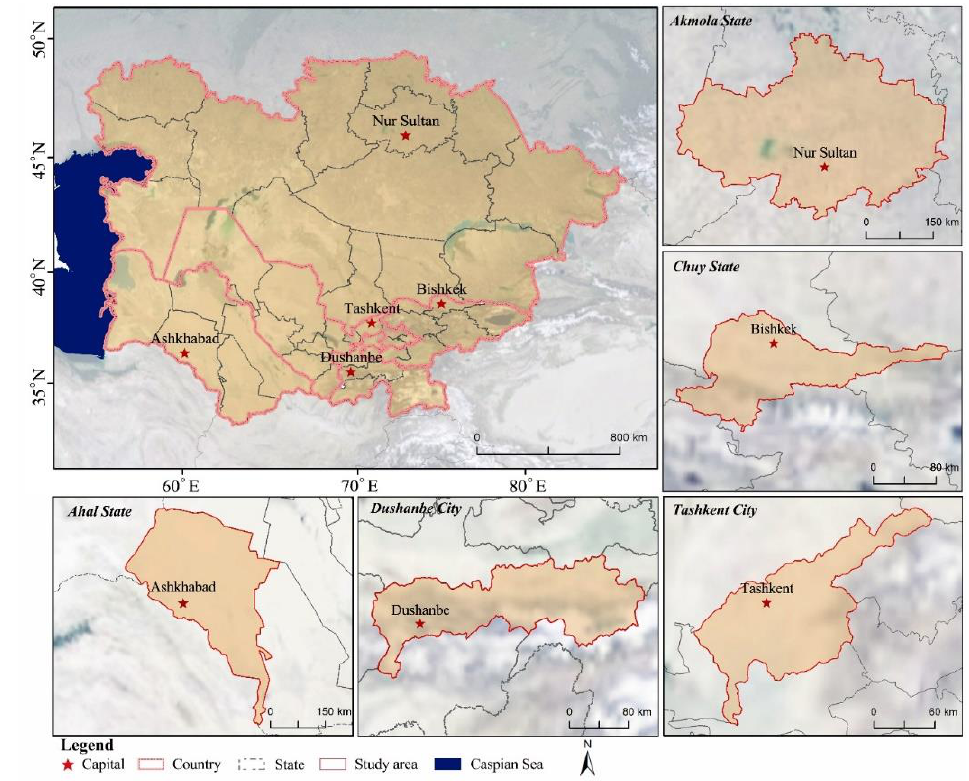
Figure 1. Locations of the study area.